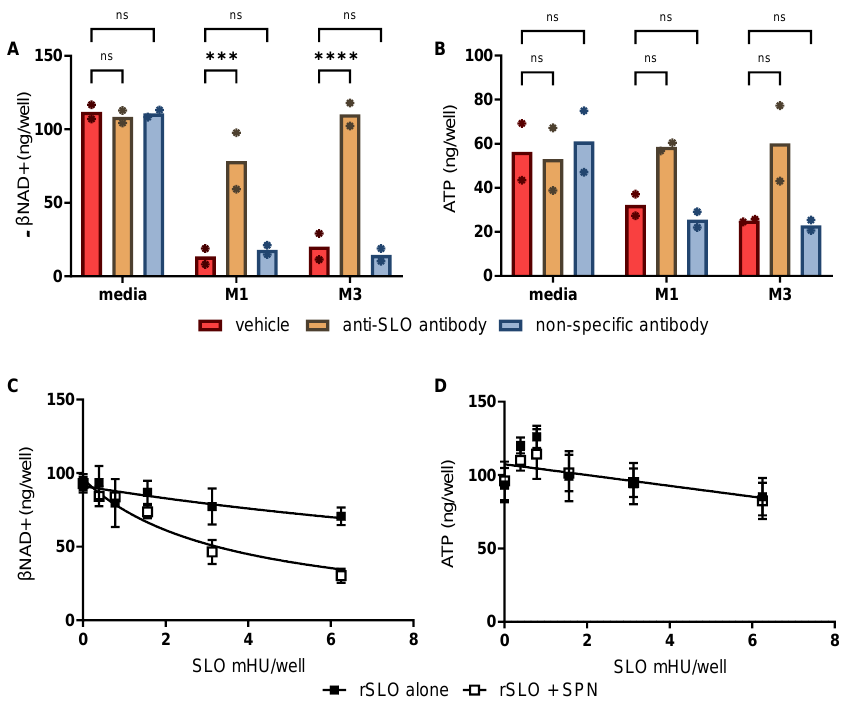
Figure 3. SLO facilitates SPN-mediated depletion of β NAD+. ( A , B ) diluted (8-fold) M1 or M3 culture supernatant was incubated at 37 ◦ C for 15 min with neutralizing anti-SLO antibody or an isotype-matched control antibody prior to their addition to cultured skeletal muscle cells. Non-inoculated culture media served as controls. Bars represent the means from an n = 2 independent experiments shown as symbols. Significance was determined by ANOVA. Dunnett’s multiple comparison test was used to compare treatments to vehicle control post hoc. *** p ≤ 0.001; **** p < 0.0001; ns = not significant. ( C , D ) Recombinant SLO (rSLO) alone, or in combination with purified SPN (0.03 U), was added to SkMCs. SLO concentrations are given as milli-hemolytic units (mHU)/well. Symbols represent the means from n = 4 independent experiments. Error bars represent SEM. EC50 ± 95% CI was determined by non-linear regression. ( C ) EC50 = 3.5 ± 0.9 mHU/well for SLO + 0.03 U SPN (open squares) and EC50 = 19.9 ± 14.2 mHU/well for SLO alone. ( D ) Near identical linear data is not reported.